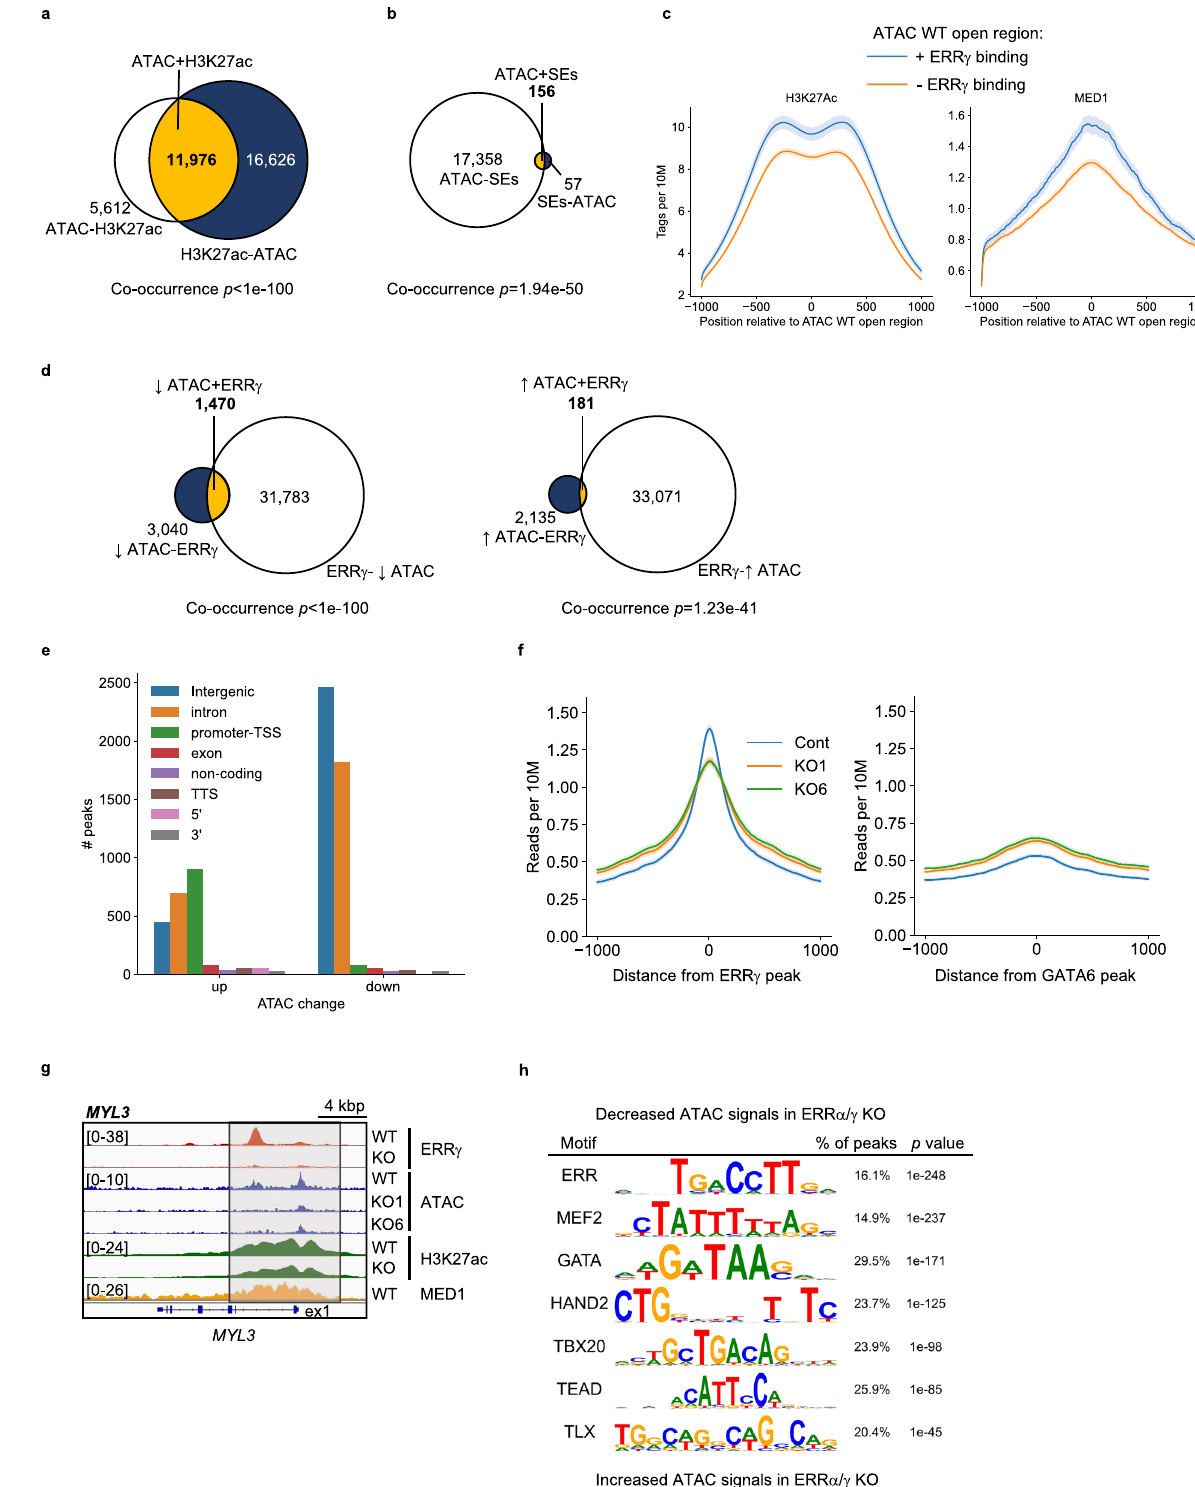
ERR γ peaks (Supplementary Fig. 6e). None of GO terms were signi fi cantly enriched with ERR γ and GATA6-shared peaks (ERR γ + GATA6), although a few cardiac genes including MYL2 , BIN1 , KCNQ1 , ATP2A2 , and ACTA1 were identi fi ed as potential targets (Supplementary Fig. 6e). These results suggest that ERR γ cooperates selectively with GATA4 in the cardiomyocyte.